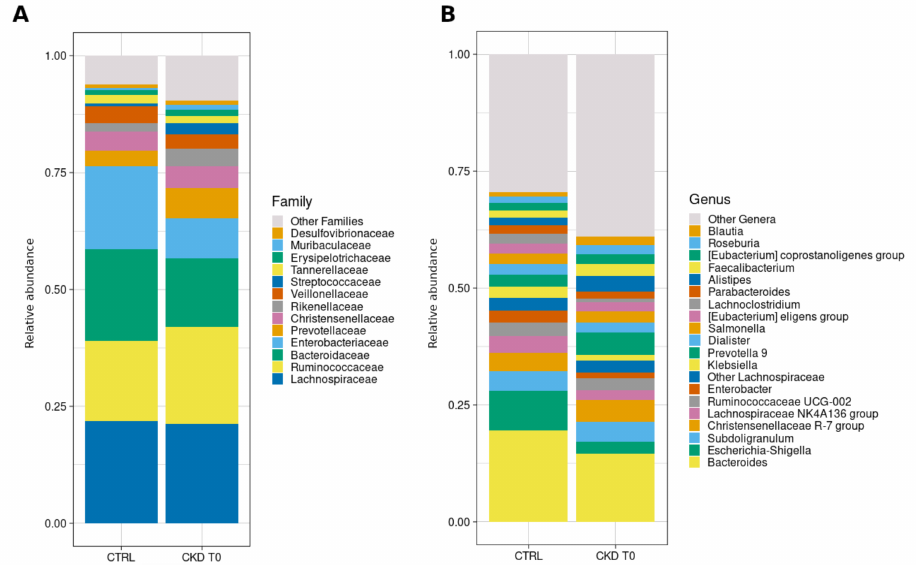
Figure 6. Taxonomic composition of CTRL subjects and CKD patients before curcumin supplementa- tion. Barplots of average microbial relative abundances at family ( A ) and genus ( B ) level for healthy subjects (CTRL) and CKD patients alone (T0).